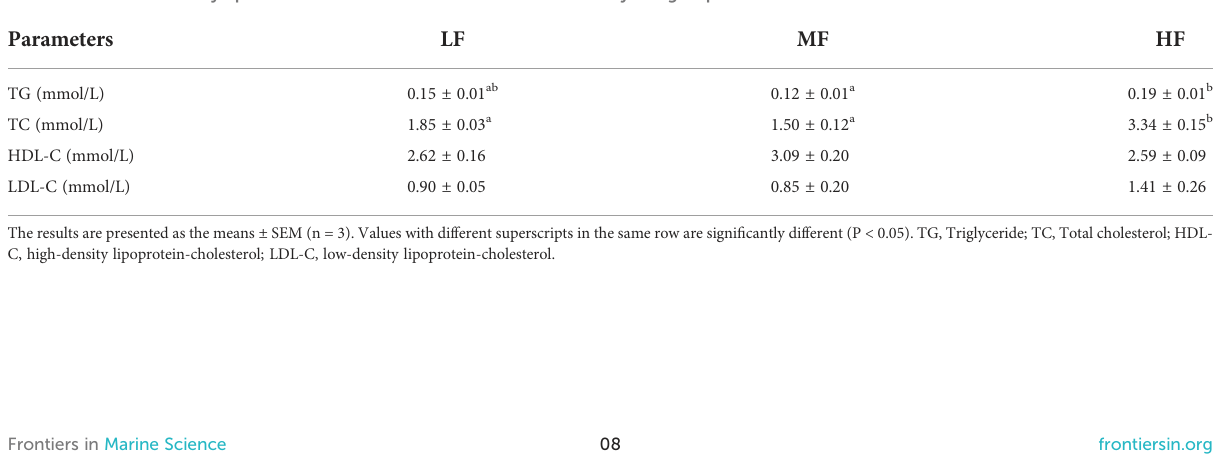
TABLE 8 Effect of dietary lipid levels on biochemical indices in serum of hybrid grouper.